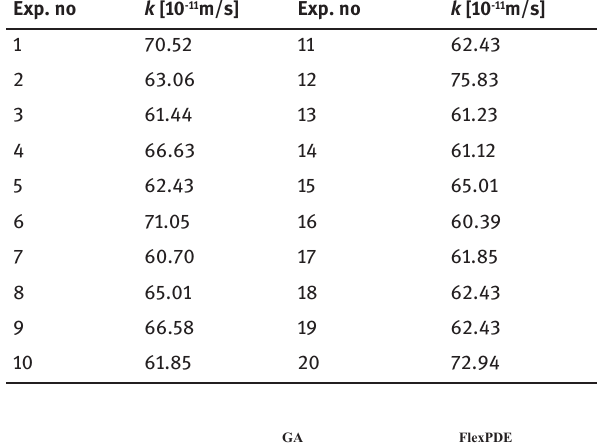
Table 1: Parameter estimation results.